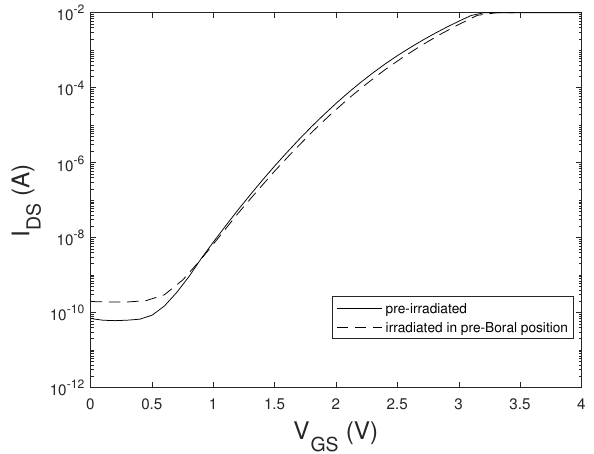
Figure 3. I DS − V GS curves at V DS = 2.0 V of a SiC_B MOSFET sample before and immediately after irradiation with thermal and fast neutrons (pre-Boral